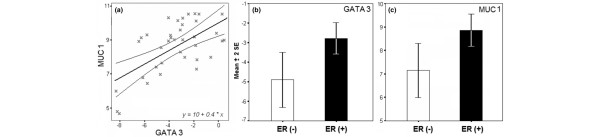
GATA3 and MUC1 real-time RT-PCR analysis in 36 invasive breast carcinomas. (a) Linear regression analysis of GATA3 and MUC1 mRNA expression levels in invasive ductal carcinoma (IDC) with 95% mean prediction interval (r = 0.6; p < 0.0001). (b,c) GATA3 (p = 0.008) (b) and MUC1 (p = 0.009) (c) mRNA expression of IDC in association with ERα status. Results are real-time RT-PCR values of the assayed gene relative to 18S rRNA used as normalizing control and are shown as means ± 2 SEM based on a log2 transformation.